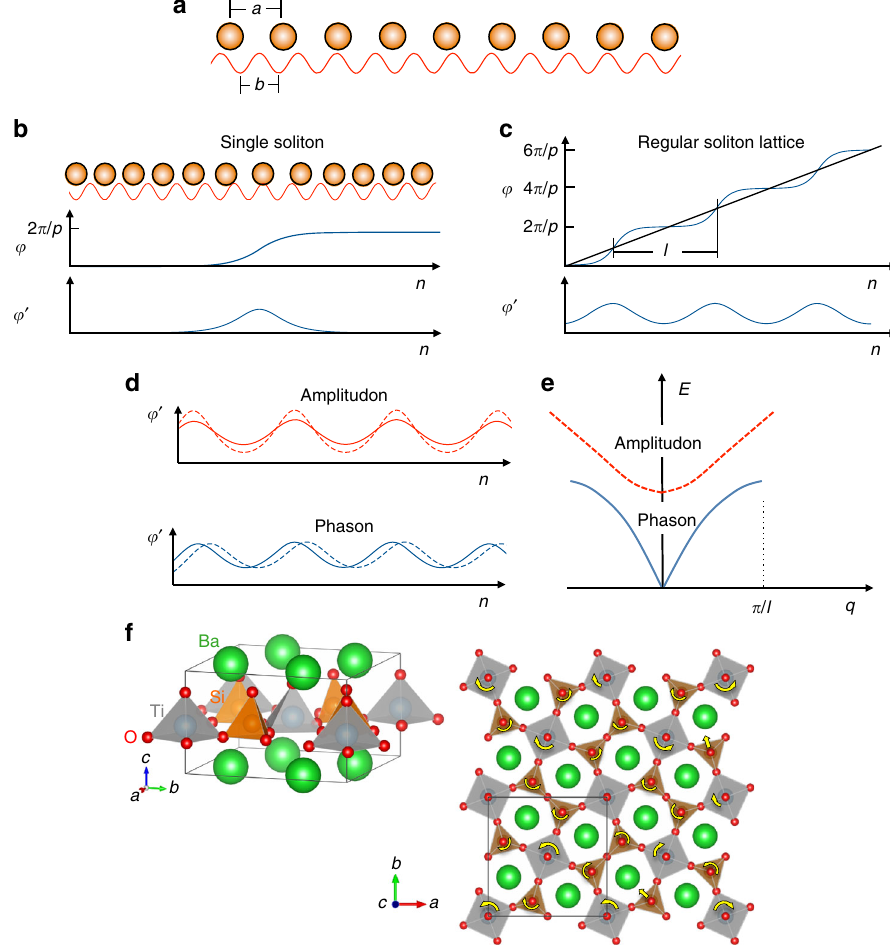
Fig. 1 Phasons, amplitudons, and the structure of fresnoite. a An incommensurate structure in one dimension, where the two lattice parameters, a and b , have a non-integer ratio. b A single soliton (or wall) separating two commensurate structures. The single soliton solution after ref. 16 stretches the lattice and introduces the phase shift, φ = 2 π / p , which separates the two commensurate structures ( φ ′ is the derivative of the phase with respect to the site coordinate, n , which is taken to be continuous in this model 16 ). c A regular soliton lattice of spacing l introduces the continuous phase shifts of the incommensurate structure in a , where the straight line represents the unperturbed incommensurate structure 16 . d Illustration of the amplitudon and phason excitations in the soliton lattice. e Dispersion curves of amplitudon and phason excitations. f Tetragonal crystal structure of fresnoite. Below ~433 K a modulation develops primarily with rotations of the tethered polyhedral in the basal plane, which occur from one unit cell to the next with a periodicity that is incommensurate with the lattice 20, 21 . The yellow arrows indicate a subset of rotations and translations in the modulation. Note how propagating a rotation around a ring of fi ve polyhedral forces the translation of one of the Si pyramids near the bottom center. Such geometric frustration leads to complex